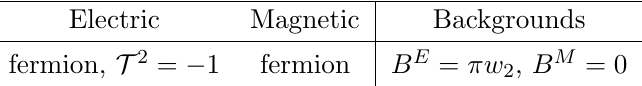
Table 2 . One non-anomalous coupling of U(1) gauge theory at (cid:18) = (cid:25) mod 2 (cid:25) to the background of time-reversing Lorentz symmetry. The electric particle has charge (1 ; 0) (that corresponds to (1 ; 0) at (cid:18) = 0), while the magnetic particle has charge (0 ; 2) (that corresponds to the dyon ( (cid:0) 1 ; 2) at (cid:18) = 0). We pick the basis of the one-form symmetry such that the backgrounds B E ; B M are of the particles are according to [4]. In this note we show that the di(cid:11)erent